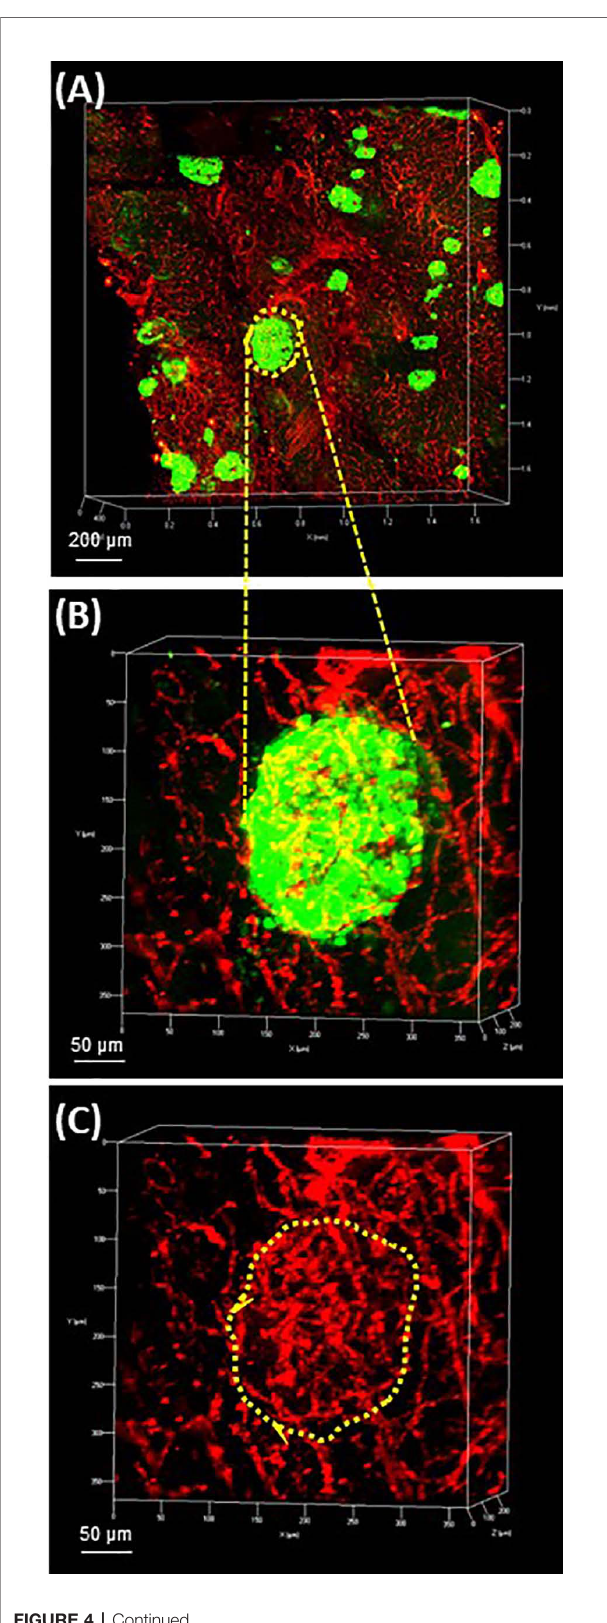
FIGURE 4 | Human pancreas vasculature. 3-D extended projection of human pancreas exocrine and endocrine vasculature are shown with X, Y and Z axes in mm (Scale bar 200 µm). (A) The extensive nature of the human pancreas vascular system is demonstrated by immunolabeling with monoclonal anti-CD31 (red) and islets are shown stained with monoclonal anti-glucagon (green) antibodies. (B) An islet identi fi ed by yellow-dotted line in (A) is shown at higher resolution in (B) (Scale bar 50 µm). (C) The islet microvasculature is shown without the glucagon overlay (Scale bar 50 µm). See also Supplementary Video 3 for (A – C) .